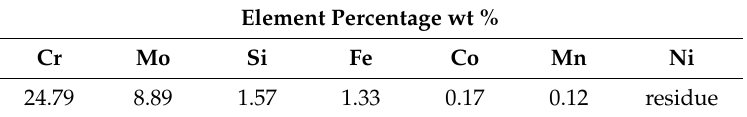
Figure 1. Test samples. Table 1. Chemical composition of tested alloy.